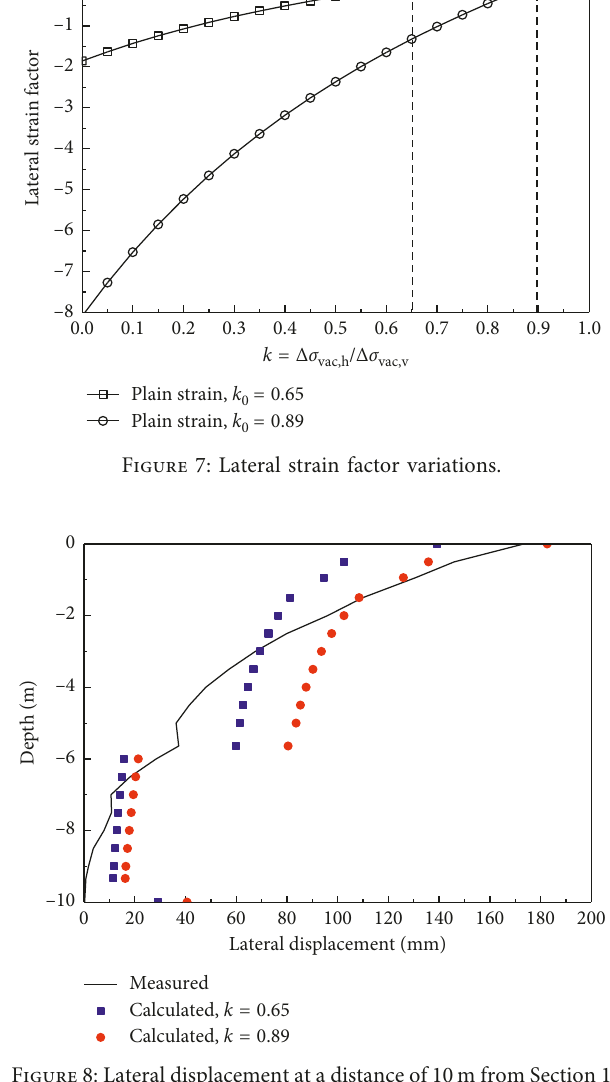
Figure 8: Lateral displacement at a distance of 10m from Section 1 boundary.